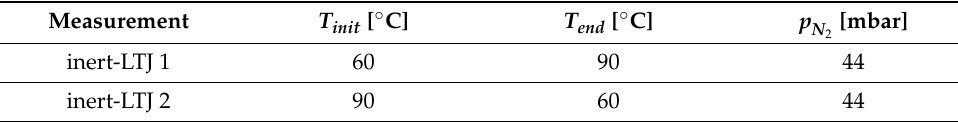
Table 2. Conditions for inert-LTJ measurements.